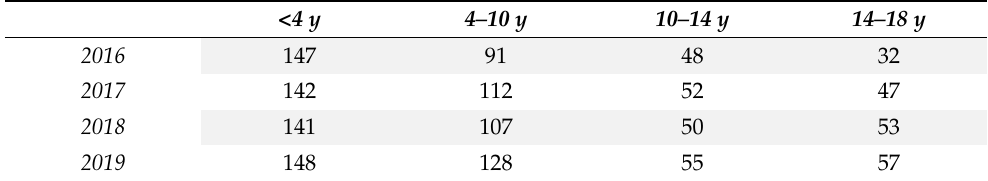
Table 1. Number of procedures per